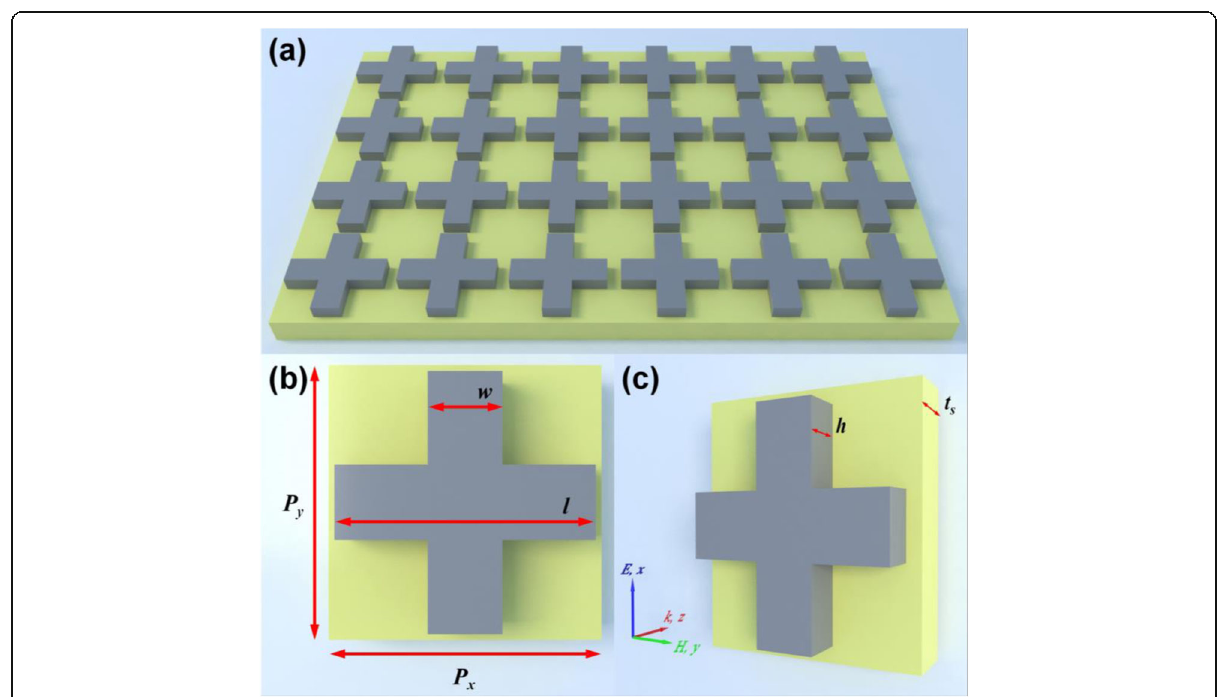
Fig. 1 Schematic illustration of visible triple-narrowband PLA. a The 2D periodic array structure. b Front. c Perspective view of the unit-cell nanostructure